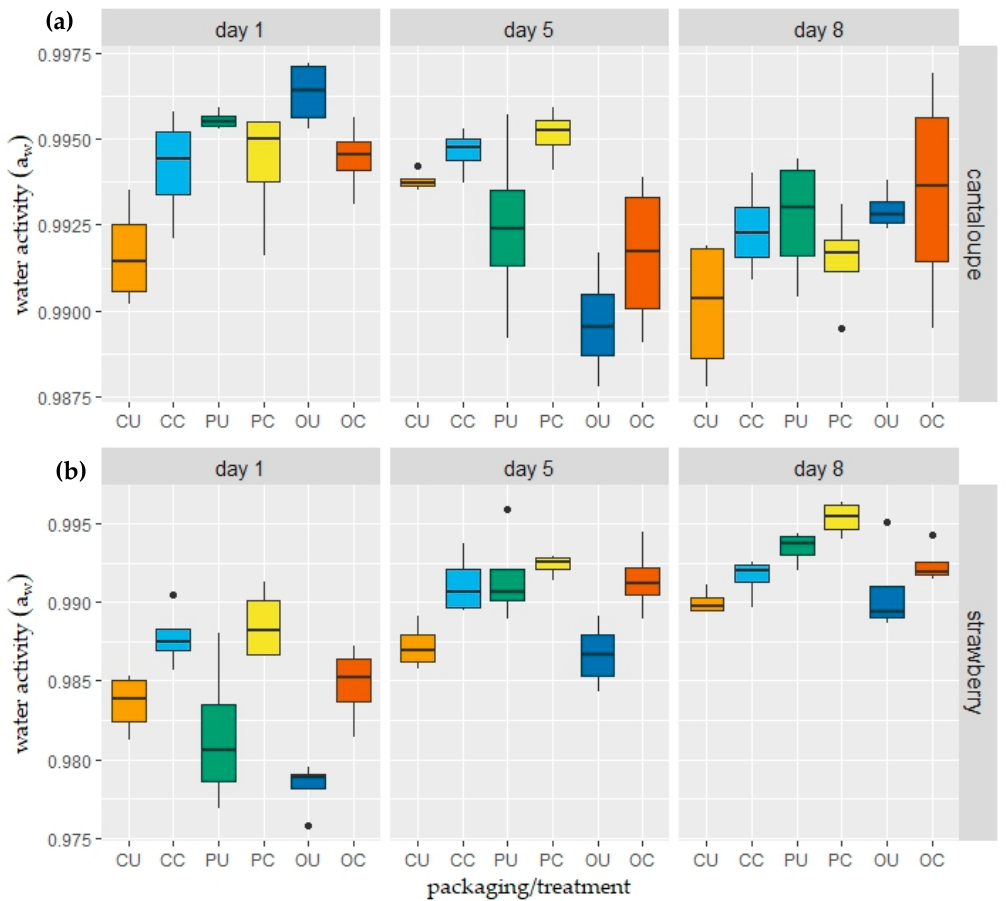
Figure 5. Box and whisker plots (median, min / max values, outliers) of water activity values of uncoated and coated ( a ) fresh-cut cantaloupe; ( b ) strawberry samples during storage at 10 ◦ C and 90% RH. Alginate-based coating solution consists of 1.25% alginate + 2 glycerol + 0.2% sunflower oil + 1% span 80 + 0.2% tween 80 and 2% calcium lactate (crosslinking agent). CU: closed package–uncoated;